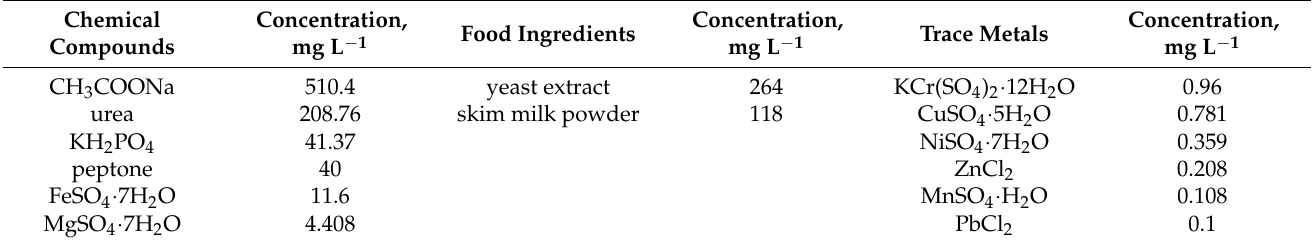
Table A2. The recipe of synthetic municipal wastewater based on the modified protocol